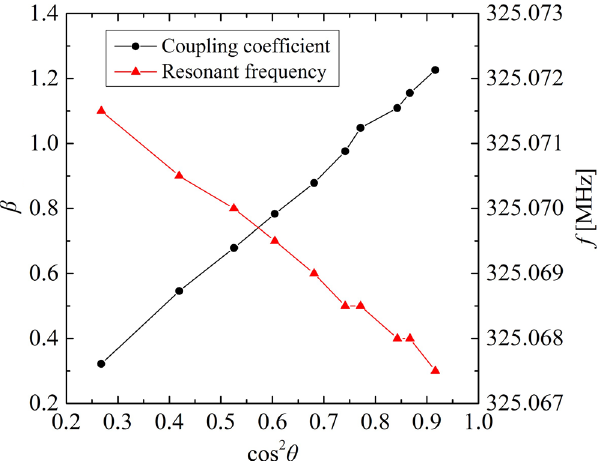
FIG. 12. Relationship between the resonant frequency and insertion depth of four tuners nearest to the input flange, and four tuners nearest to the output flange of the